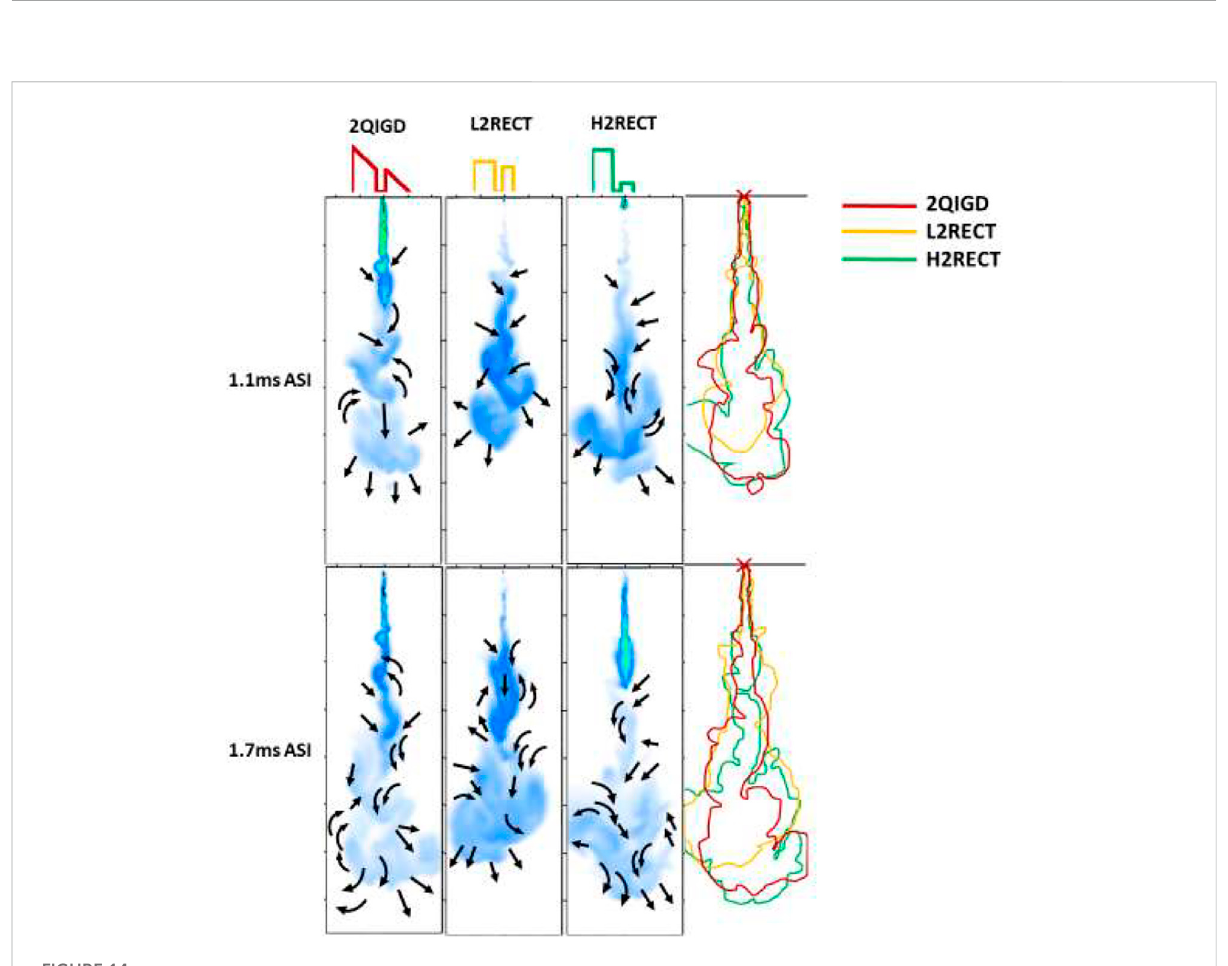
FIGURE 14 Velocity vector direction of vortex and spray area